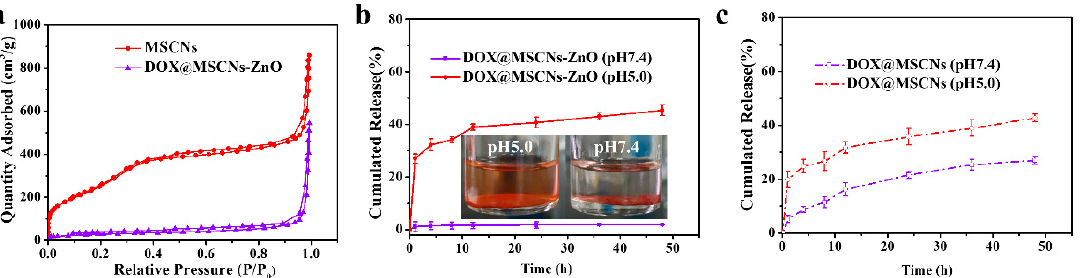
Figure 10. ( a ) Nitrogen adsorption desorption isotherms of MSCNs and DOX@MSCNs-ZnO. ( b